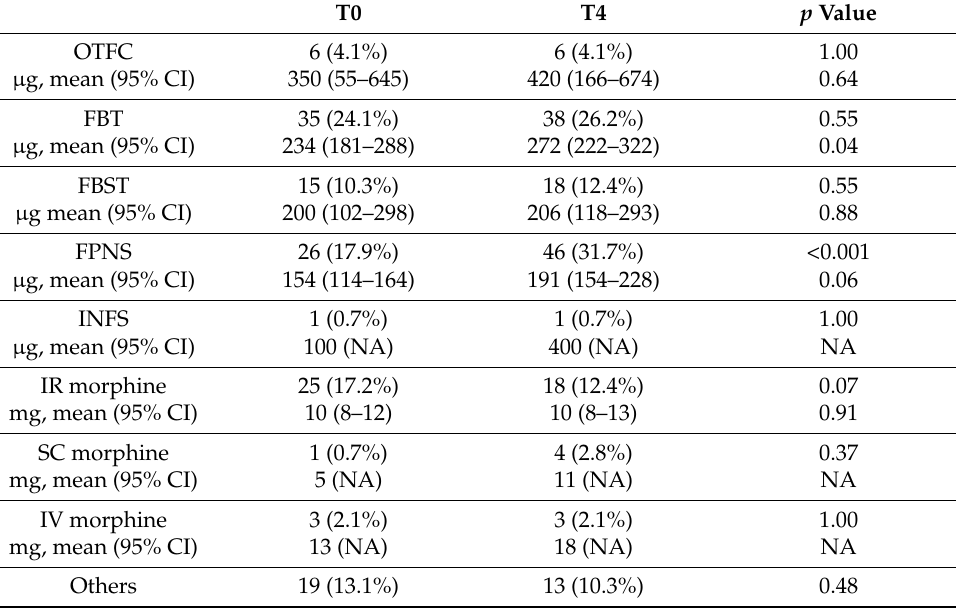
Table 3. Opioids and doses used for BTcP at T0 and T4. OTFC = oral transmucosal fentanyl citrate, FBT = fentanyl buccal tablet, FBST = sublingual fentanyl, FPNS = fentanyl pectin nasal spray, INFS = intranasal fentanyl, IR = immediate release morphine, SC Morphine = subcutaneous morphine, IV = intravenous morphine, NA = not applicable the calculation of 95% CI.